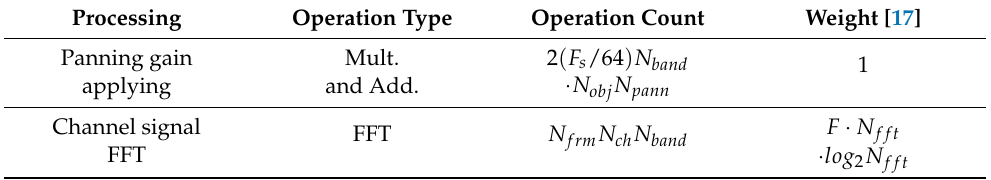
Figure 5. Block diagram of the MPEG-H 3DA BR comprising the PGC and BSC. Table 1. Computational complexity of the PGC implemented on the MPEG-H 3DA BR.